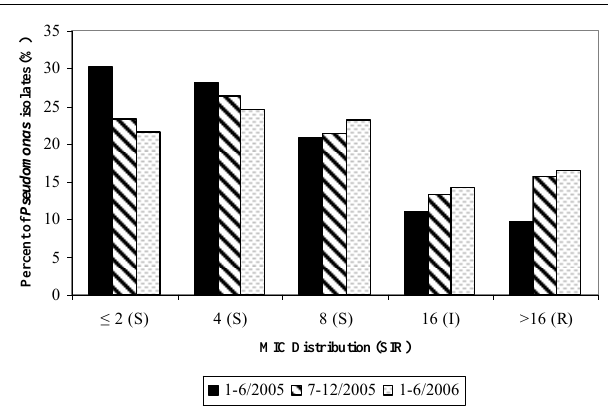
Figure 2. Cefepime susceptibilities of P. aeruginosa (MIC Distribution): UCDMC (semiannually, January 2001–June 2006).